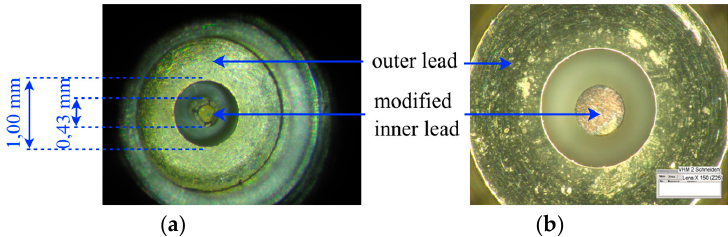
Figure 6. Modified 1.0 mm calibration kit (through) to measure ACP properties up to 110 GHz, ( a ) modified 1.0 mm male standard ( b ) modified 1.0 mm female standard [6].